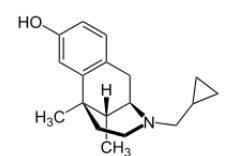
Figure 11. Cyclazocine.